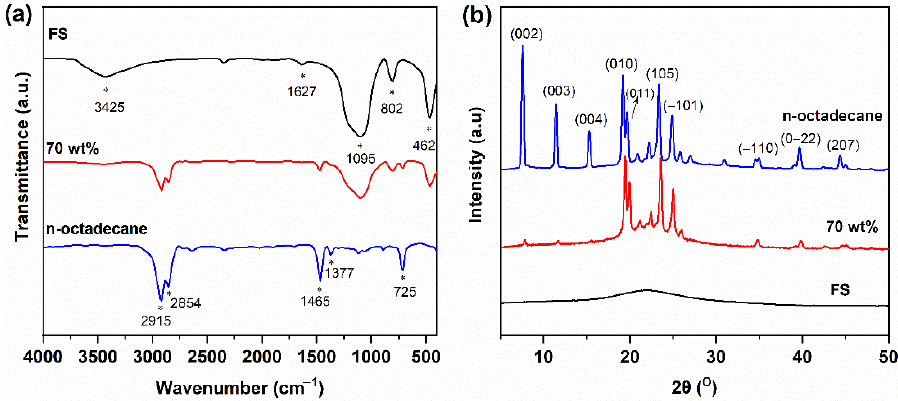
Figure 4. ( a ) Fourier transform infrared (FT-IR) spectra of FS, n-octadecane, and 70 wt% PCC. ( b ) X-ray diffraction (XRD) patterns of FS, n-octadecane, and 70 wt% PCC.